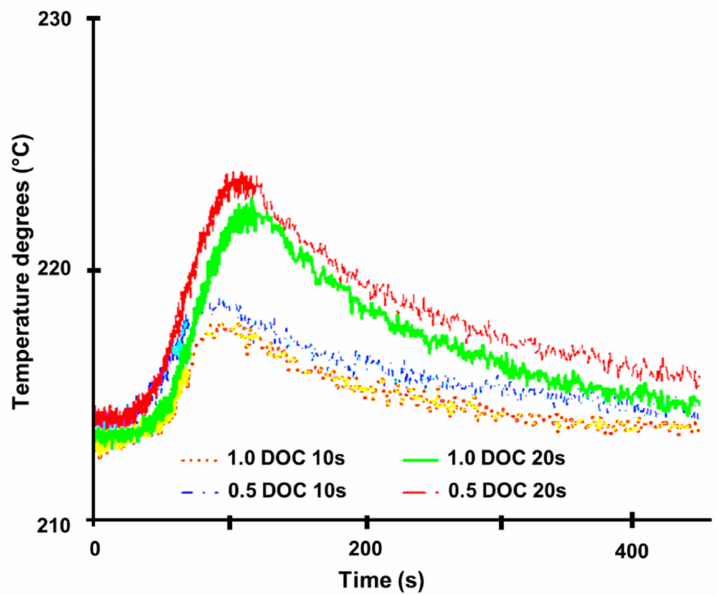
Figure 11. Temperatures measured at the SCR inlet tests, adapted from Benjamin et al.